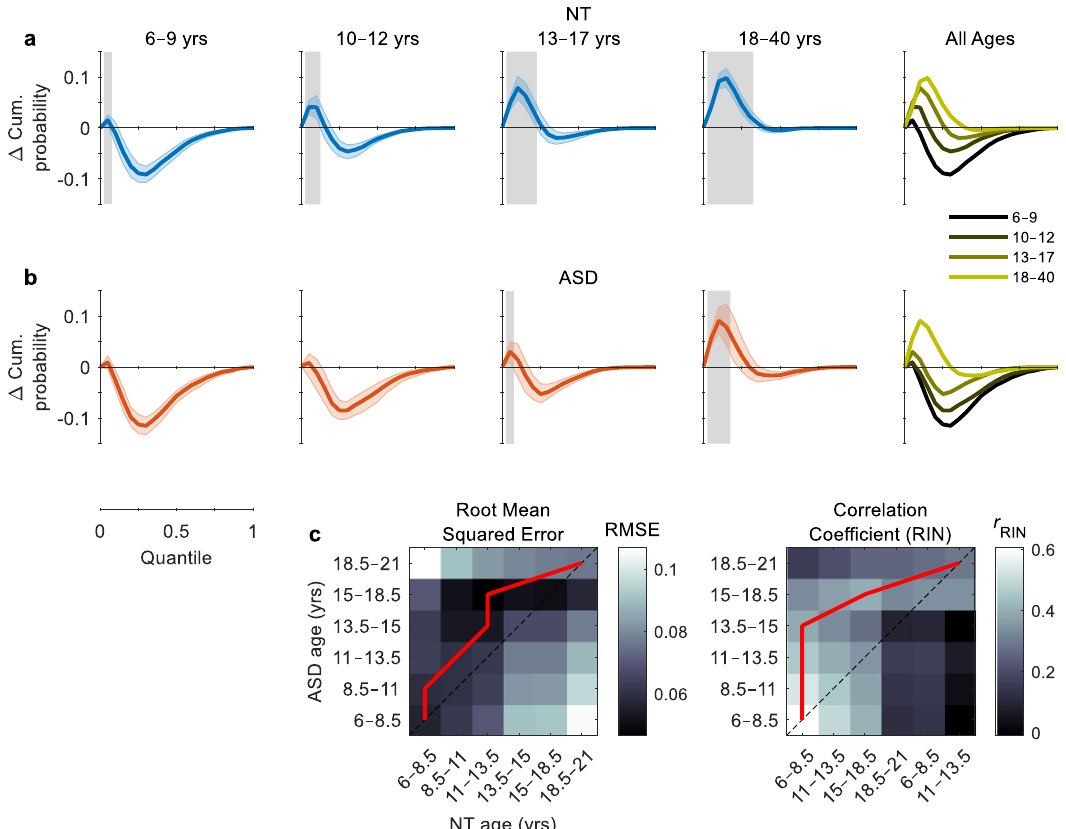
Fig. 2 Testing the race model. a , b Multisensory facilitation was quanti fi ed by the difference between the CDFs of the multisensory condition and the independent race model. Positive deviations re fl ect the proportion of multisensory RTs that were faster than predicted by the race model. Gray shaded regions indicate signi fi cant positive deviations ( p < 0.05, right-tailed permutation tests, t max corrected). Coloured error bounds indicate 95% CIs (bootstrapped). c Root mean squared error (left panel) and RIN-transformed Pearson correlation coef fi cient (right panel) between the difference functions for NT and ASD participants of different ages (range: 6 – 21 years, increment: 2.5 years). Red lines indicate the minimum (left panel) and maximum (right panel) values of each row (i.e., the NT groups that were most similar to each ASD group). Divergence of the red line above the dotted midline indicates a potential delay in age-related changes in